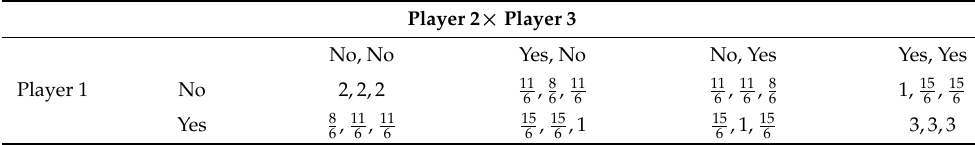
Table 6. The 3-person induced non-cooperative game D.